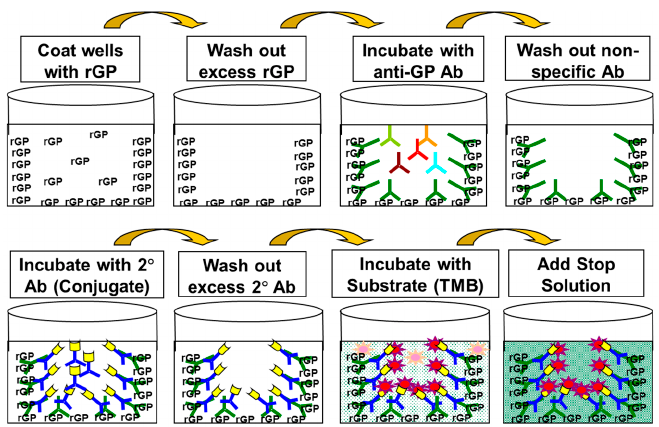
Figure 1. Illustration of General Anti-GP IgG ELISA Method.